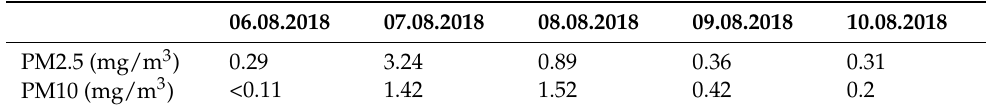
Table 2. Results from the gravimetric measurements in summer.